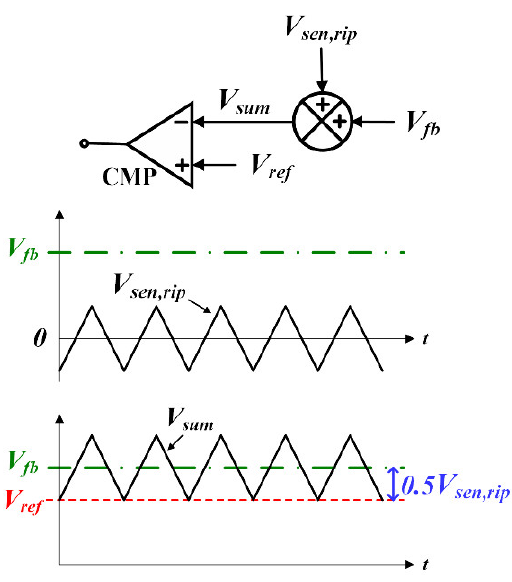
Figure 5. Concept of VICR control.